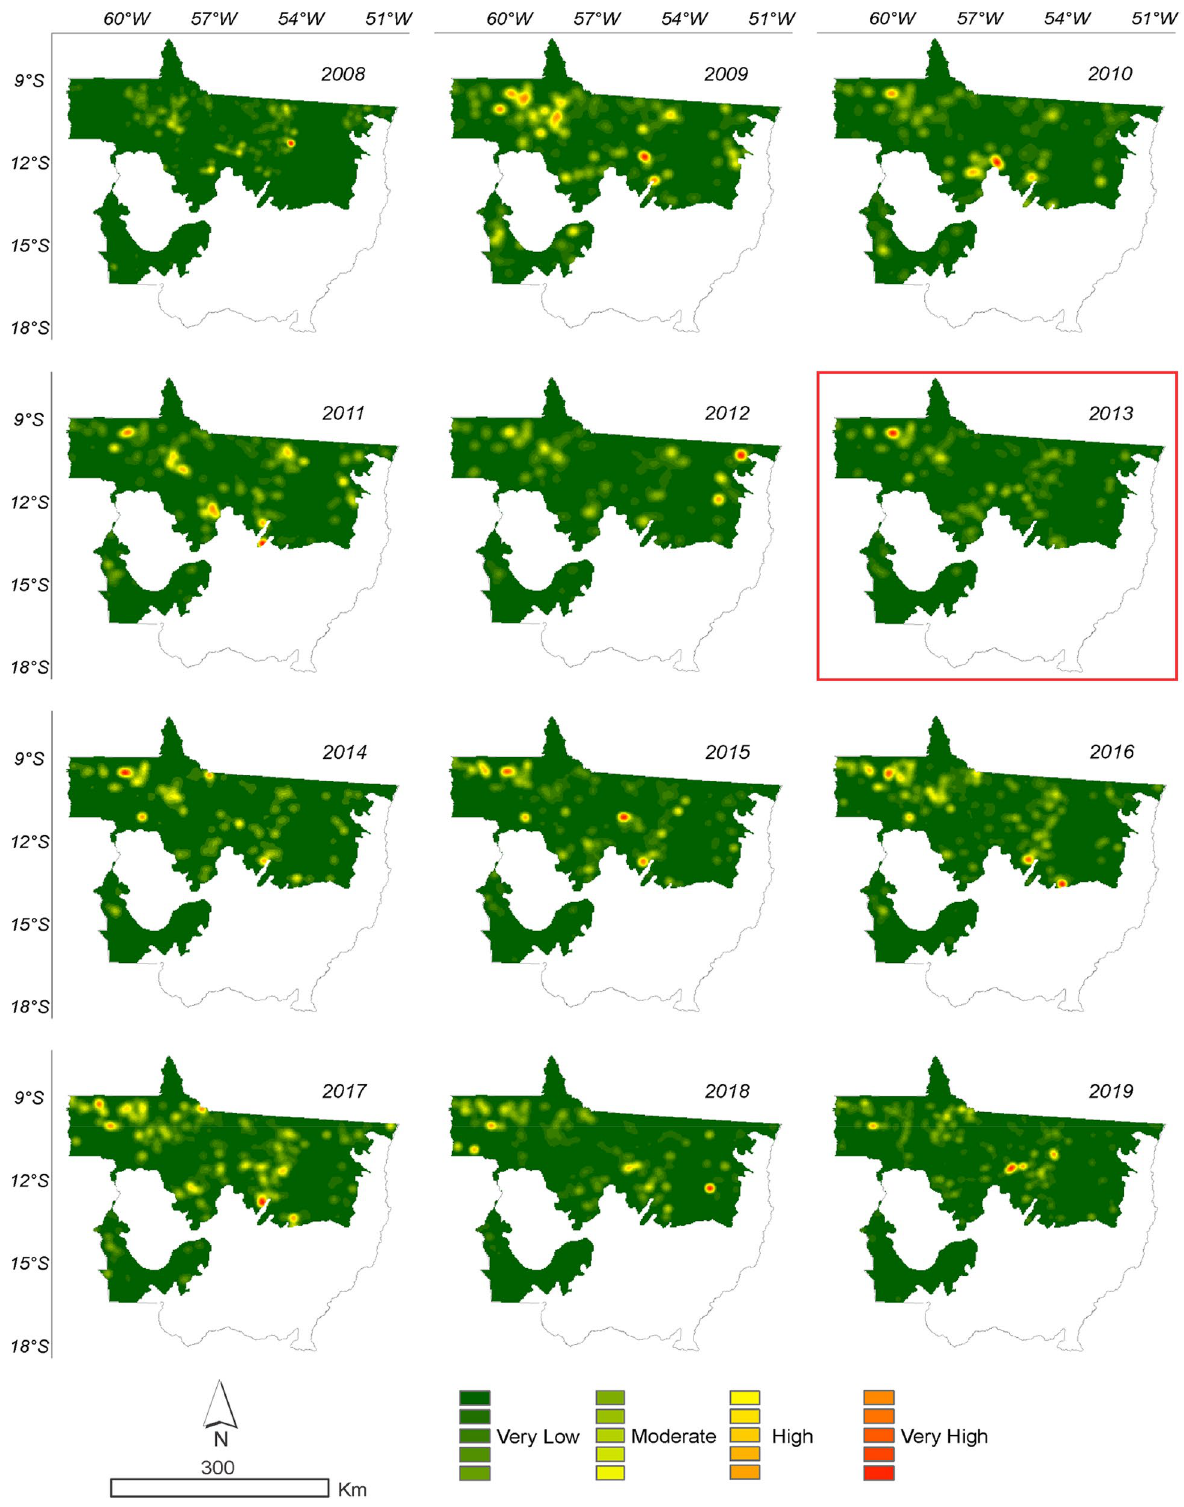
Figure 10. Annual deforestation density in the Amazonia biome in the State of Mato Grosso from 2008 to 2019 with data from PRODES. The year highlighted by the red square corresponds to the likely change point in the time series identified by the Pettitt test (Table